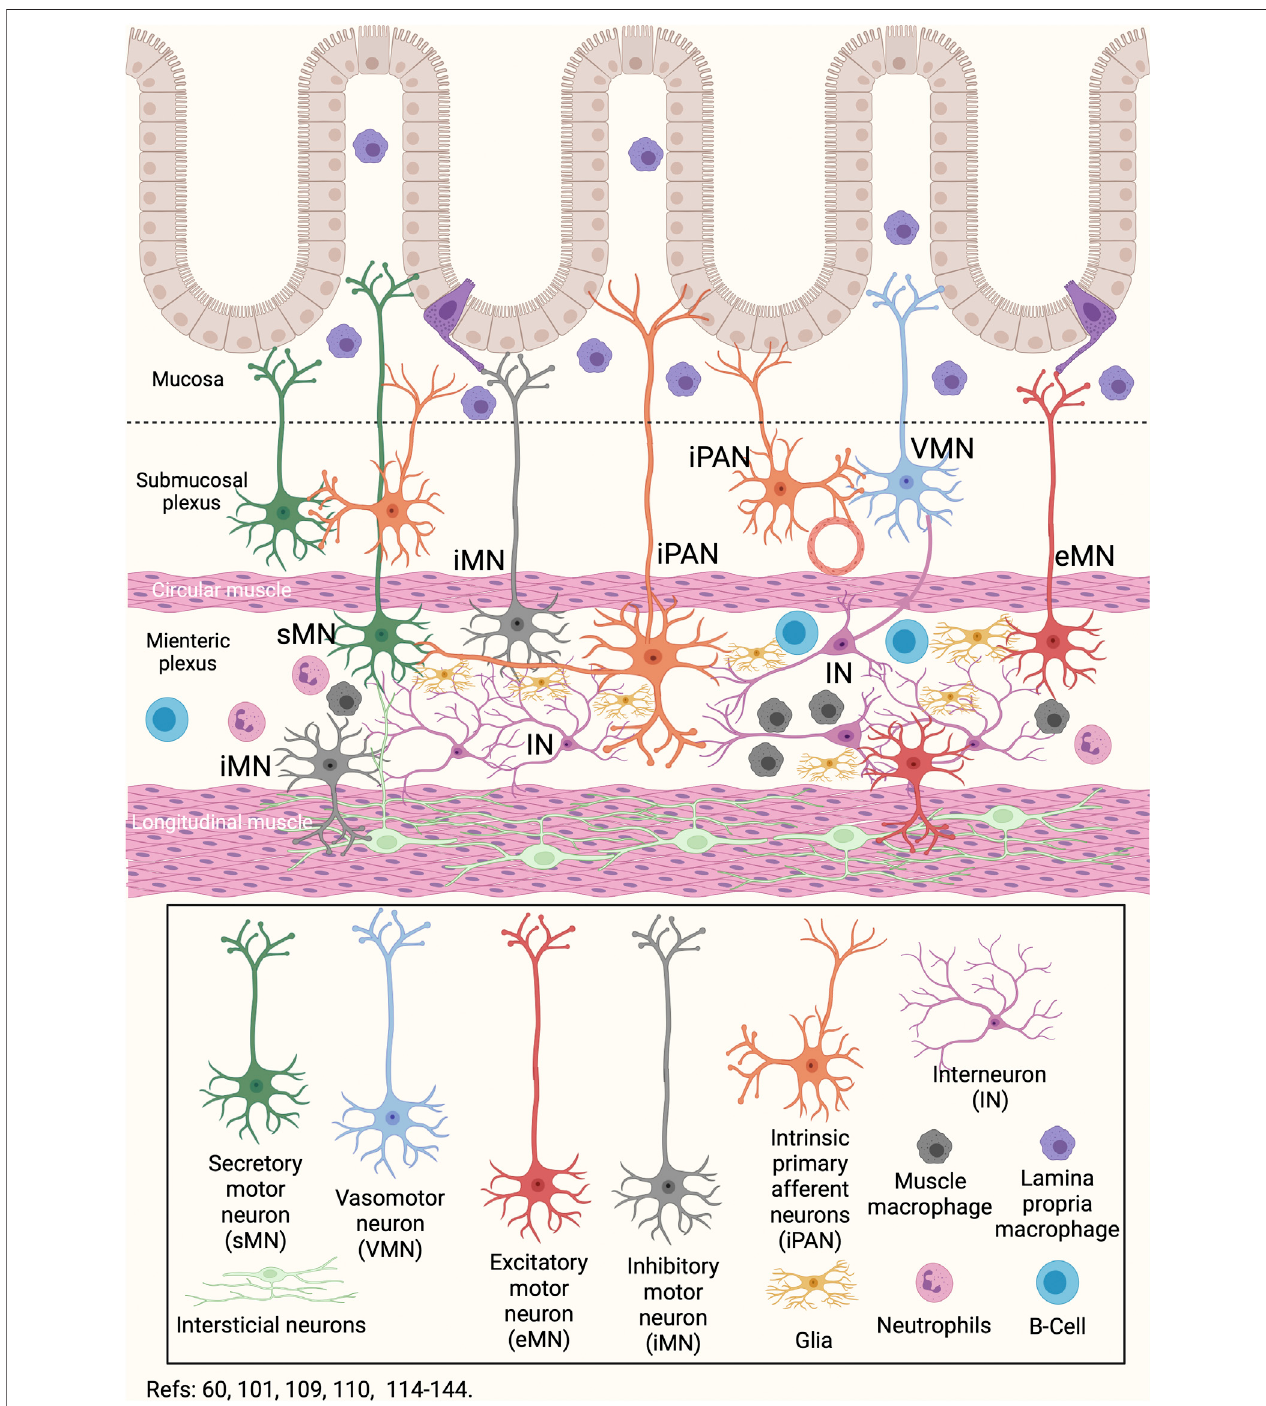
FIGURE 3 | Gut-Brain neuroimmune communication. The network of neurons that innervates the intestine involves a series of neurons with different locations and functions. Secretory motor neurons, primary intrinsic afferent neurons, and vasomotor neurons are located in the submucosal plexus. In the myenteric plexus, the interneurons, the inhibitory, excitatory, secretory motor, and the intrinsic primary afferent neurons are located, in addition to the glia. In both the submucosal and myenteric plexus there are resident macrophages and neutrophils. In particular, myenteric plexus macrophages have the ability to migrate to the submucosa and regulate the neuronal and immune response induced by changes in the gut microbiota or food ingestion. Besides, the B cells can generate humoral responses at the myenteric plexus level. Finally, in the longitudinal musculature there are interstitial neurons. In this way, changes in the lumen are sensed by immune cells or neurons present in the mucosa and submucosa, and are regulated by neurons and immune cells located in the myenteric plexus.